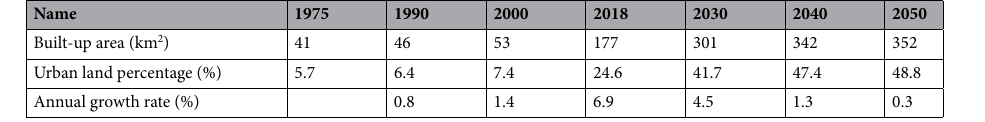
1 /� t A j − 1 . A i (cid:30)